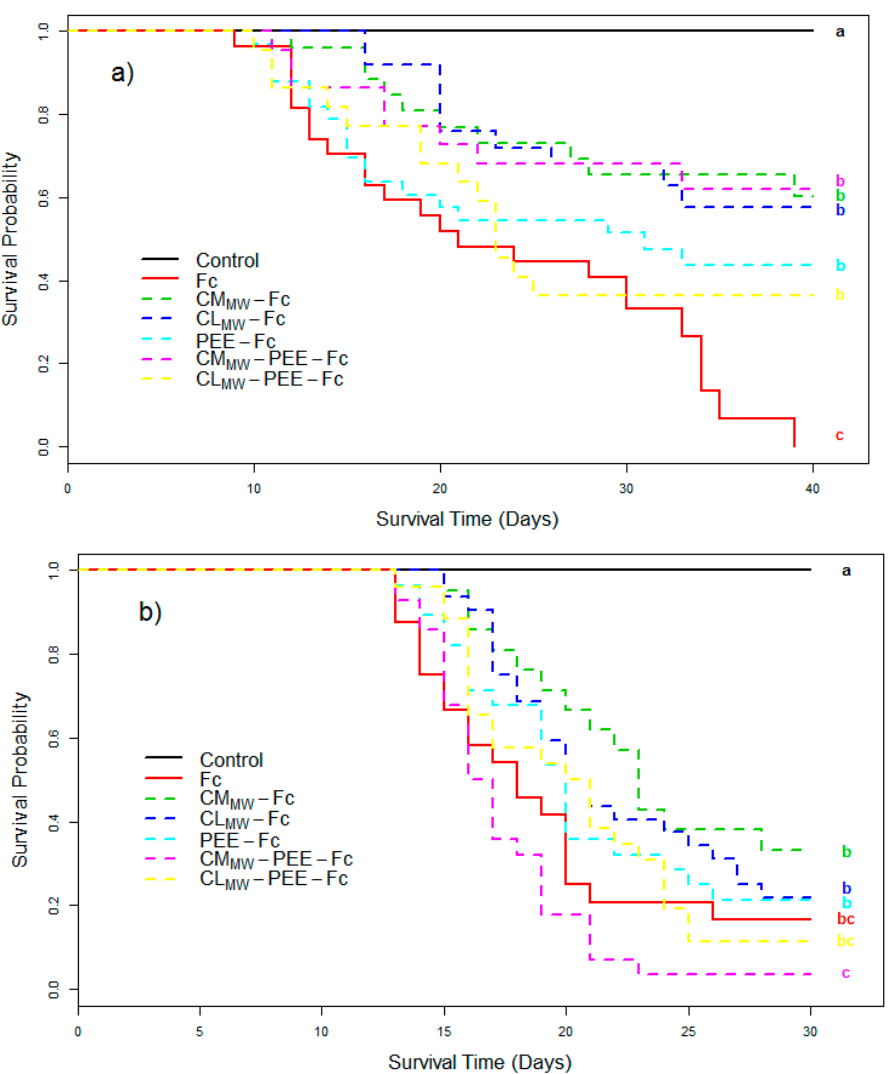
Figure 3. Plot of survival probability, determined using the Kaplan-Meier estimate of the survival function, for ( a ) P. sylvestris and ( b ) P. radiata seedlings inoculated with Fusarium circinatum (Fc) as a function of the seed coating treatments. CM MW and CL MW stand for medium and low molecular weight chitosan, respectively, PEE stands for propolis ethanolic extract. No mortality was registered for mock-inoculated and coating treatments (i.e., ( ii ) to ( vi )). These curves were not shown to avoid multi-overlaps with the curve of the control treatment. Averages with the same letter were not significantly different according to the Kaplan–Meier estimator ( α ≤ 0.05).